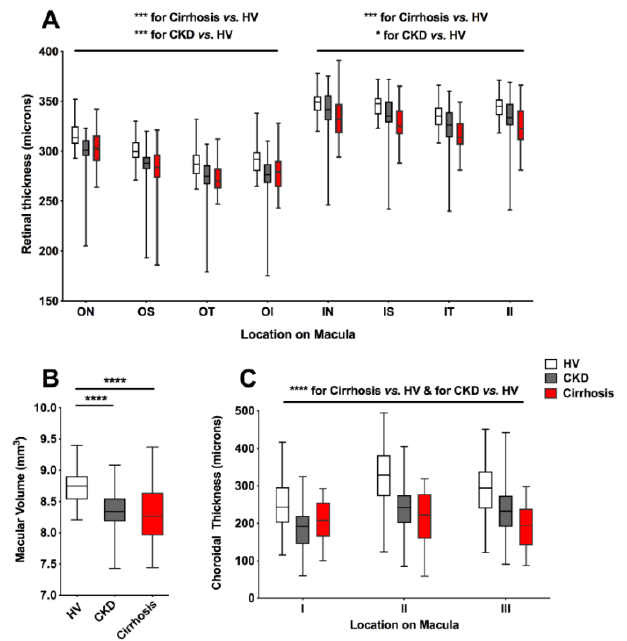
Figure 2. ( A ) Box and whiskers plot comparison of retinal thickness at each macular location between participants with cirrhosis, healthy volunteers (HV) and chronic kidney disease (CKD). ON; outer nasal, OS; outer superior, OT, outer temporal, OI; outer inferior, IN; inner nasal, IS; inner superior, IT; inner temporal, II; inner inferior. ( B ) Box and whiskers plot comparison of macular volume. ( C ) Box and whiskers plot comparison of choroidal thickness. All whiskers represent minimum to maximum. * p ≤ 0.05, *** p ≤ 0.001, **** p ≤ 0.0001.